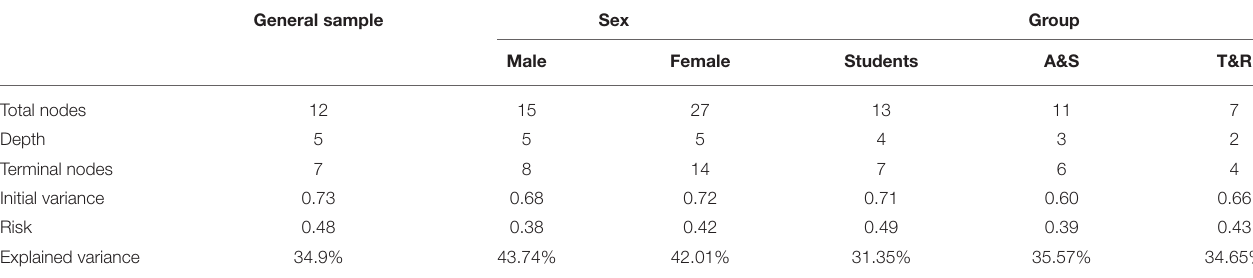
TABLE 1 | Description of the trees for the negative affective states. General